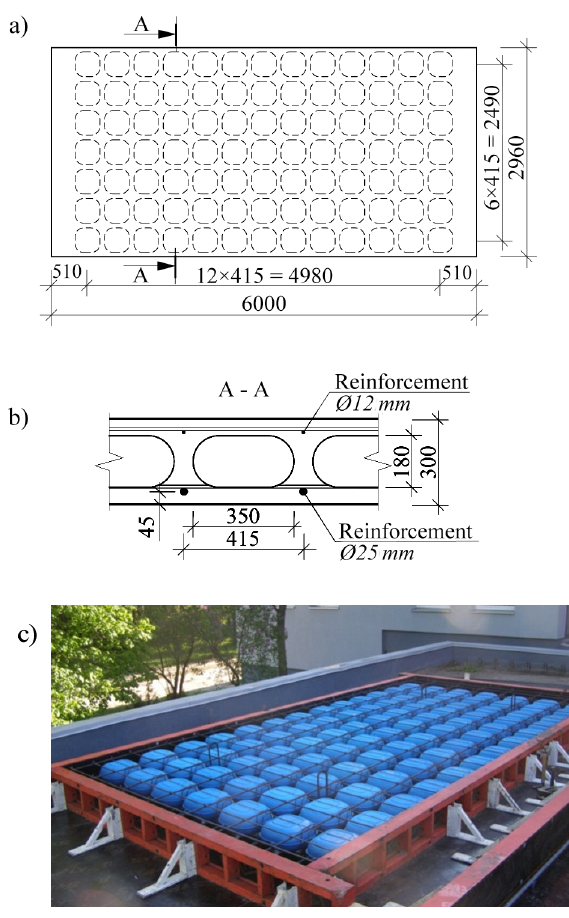
Fig. 1. The overall image of a specimen: a) the scheme of slab; b) slab cross section; c) the layout of plastic inserts